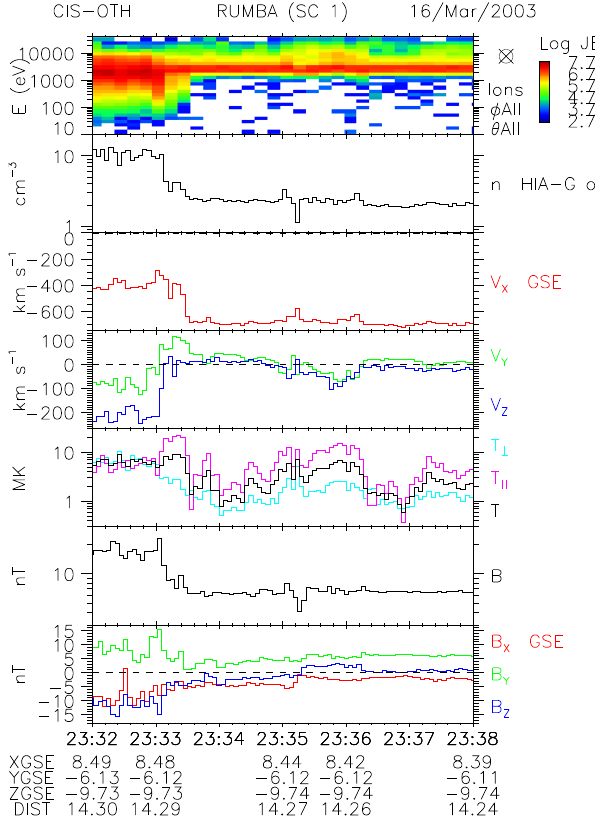
Fig.6. Fig. 6. 16 March 2003 23:32–23:38UT summary plot. Same format as for Fig. 1.